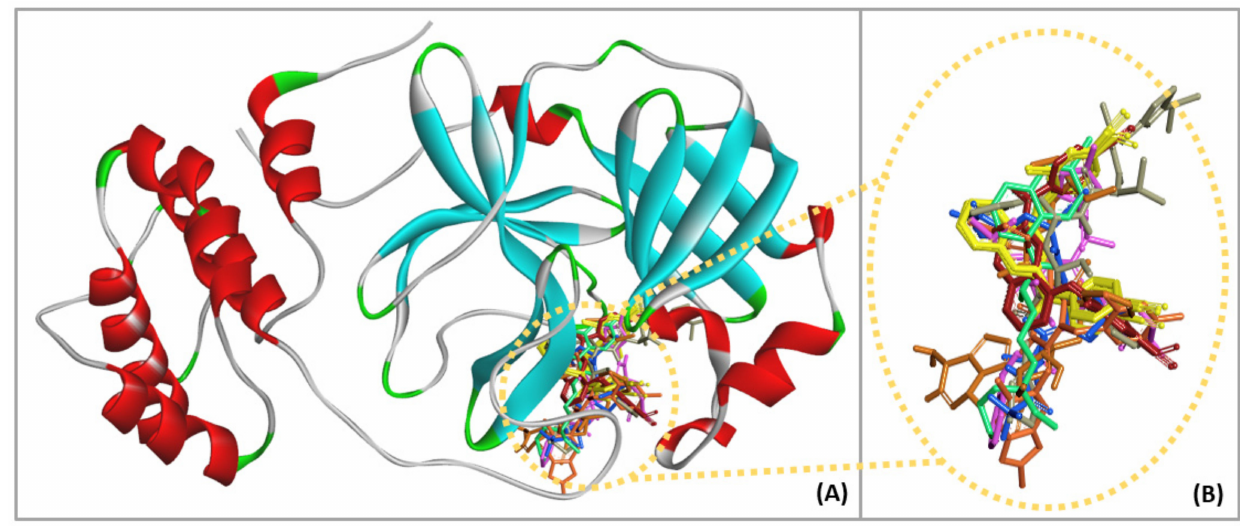
Figure 2. ( A ) The docking conformation of the analyzed ligands in M pro using molecular docking. ( B ) Overlaying of the conformations of current medicaments: Hydroxychloroquine (green). Riton- avir (grey), remdesivir (brown), S-217622 (orange), N3 (pink), PF-07321332 (blue), and interesting compounds ( 1 – 4 ) (red) and ( 5 – 8 ) (yellow) in the binding pocket of M pro . Table 2. Binding interaction between ligands with M pro in 5.0